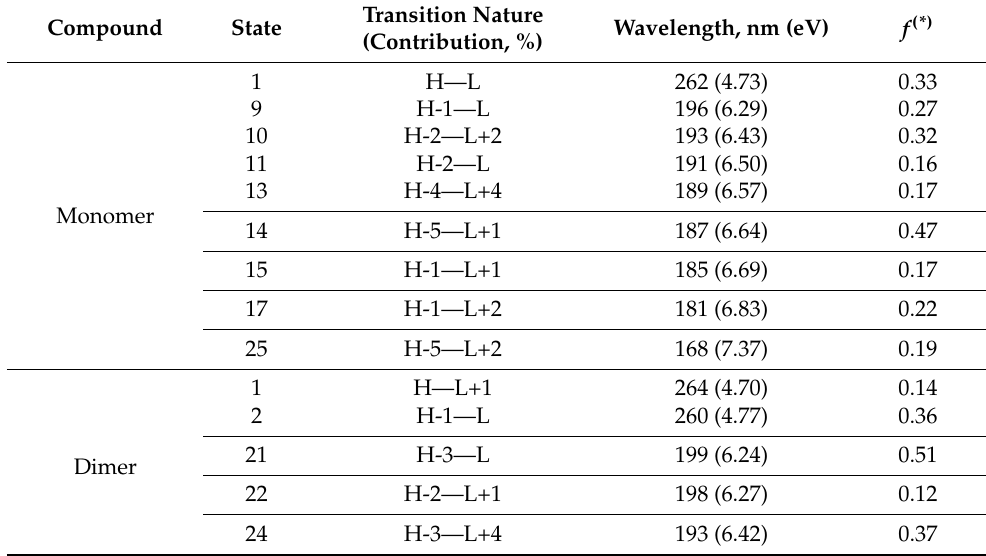
Table 2. Results of TDDFT calculations of the monomer (anion diclofenac · 3H 2 O) and its dimer.